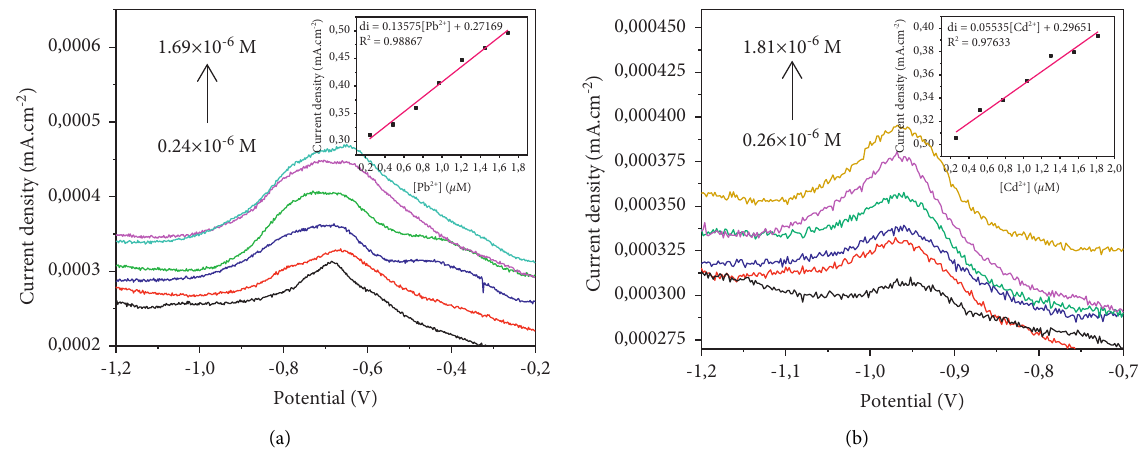
Figure 5: Effect of concentration (Hg/Hg